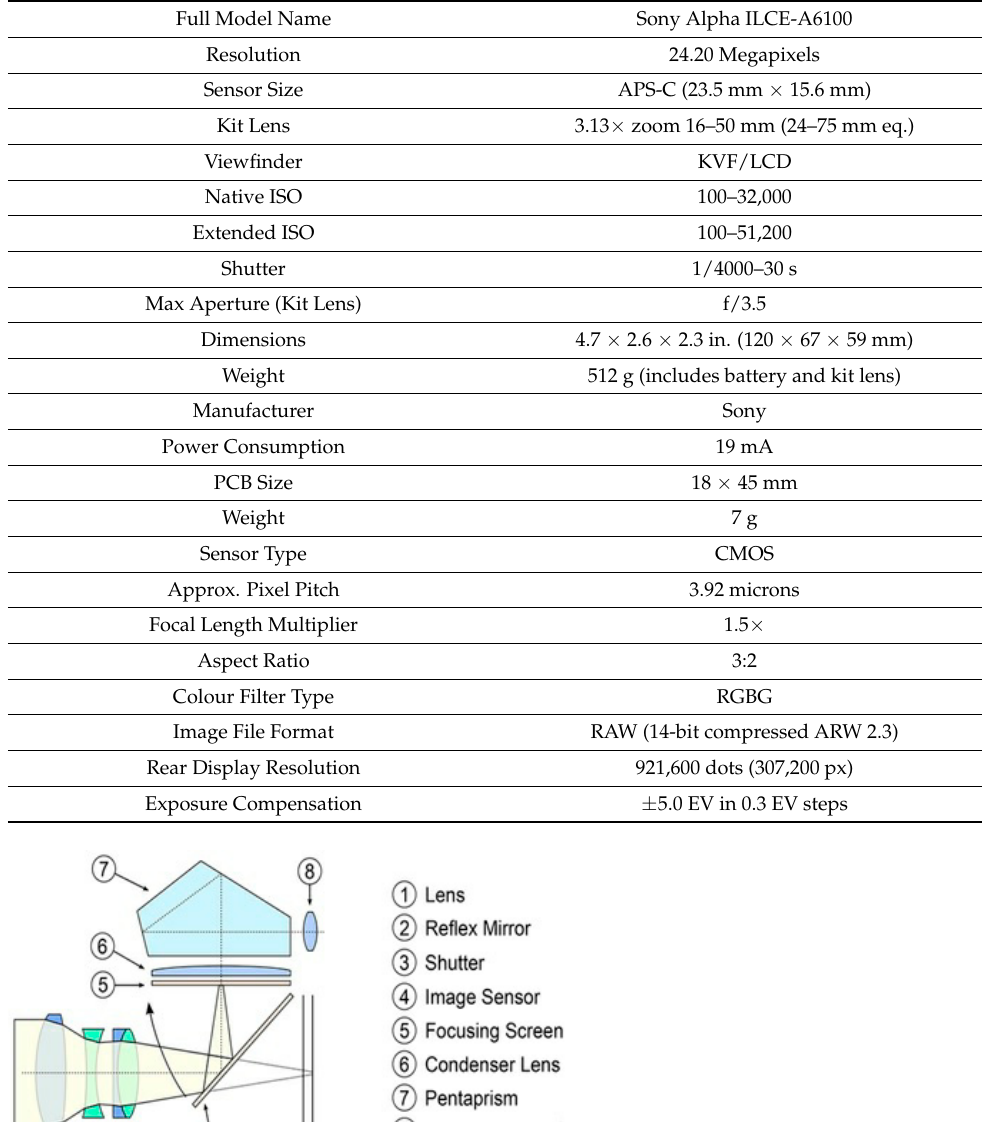
Table 1. SONY a6100 Specifications.